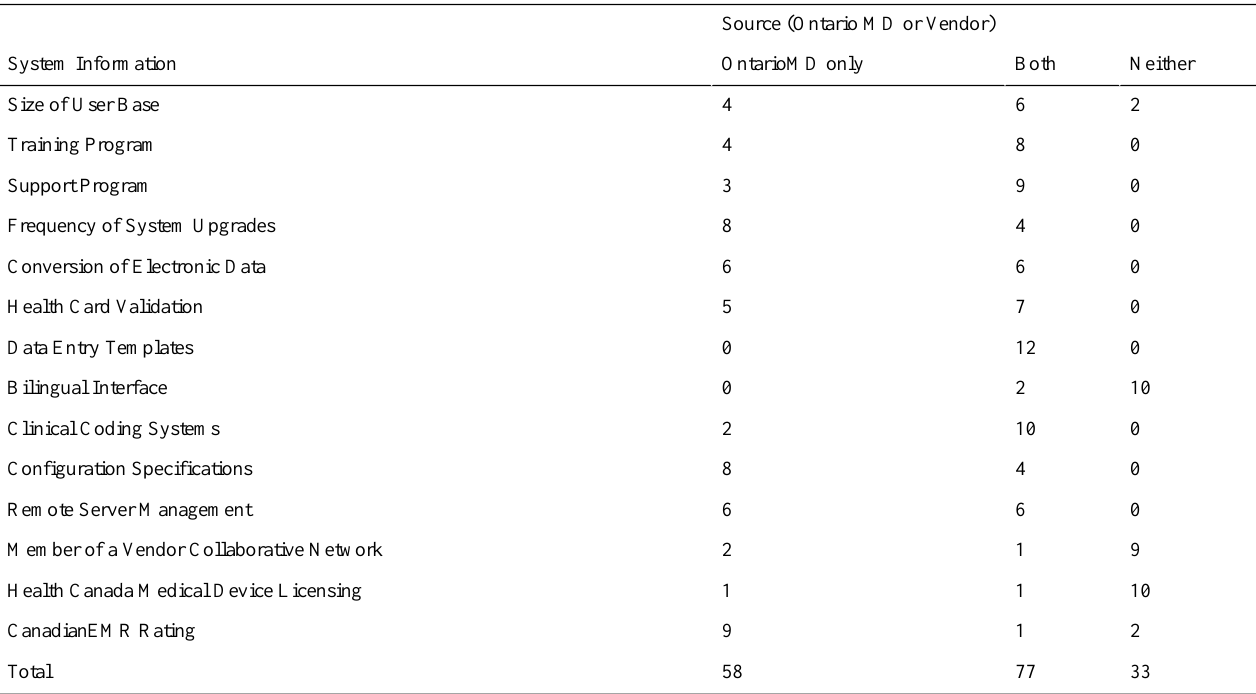
Table 5. Information overlap between OntarioMD and vendor